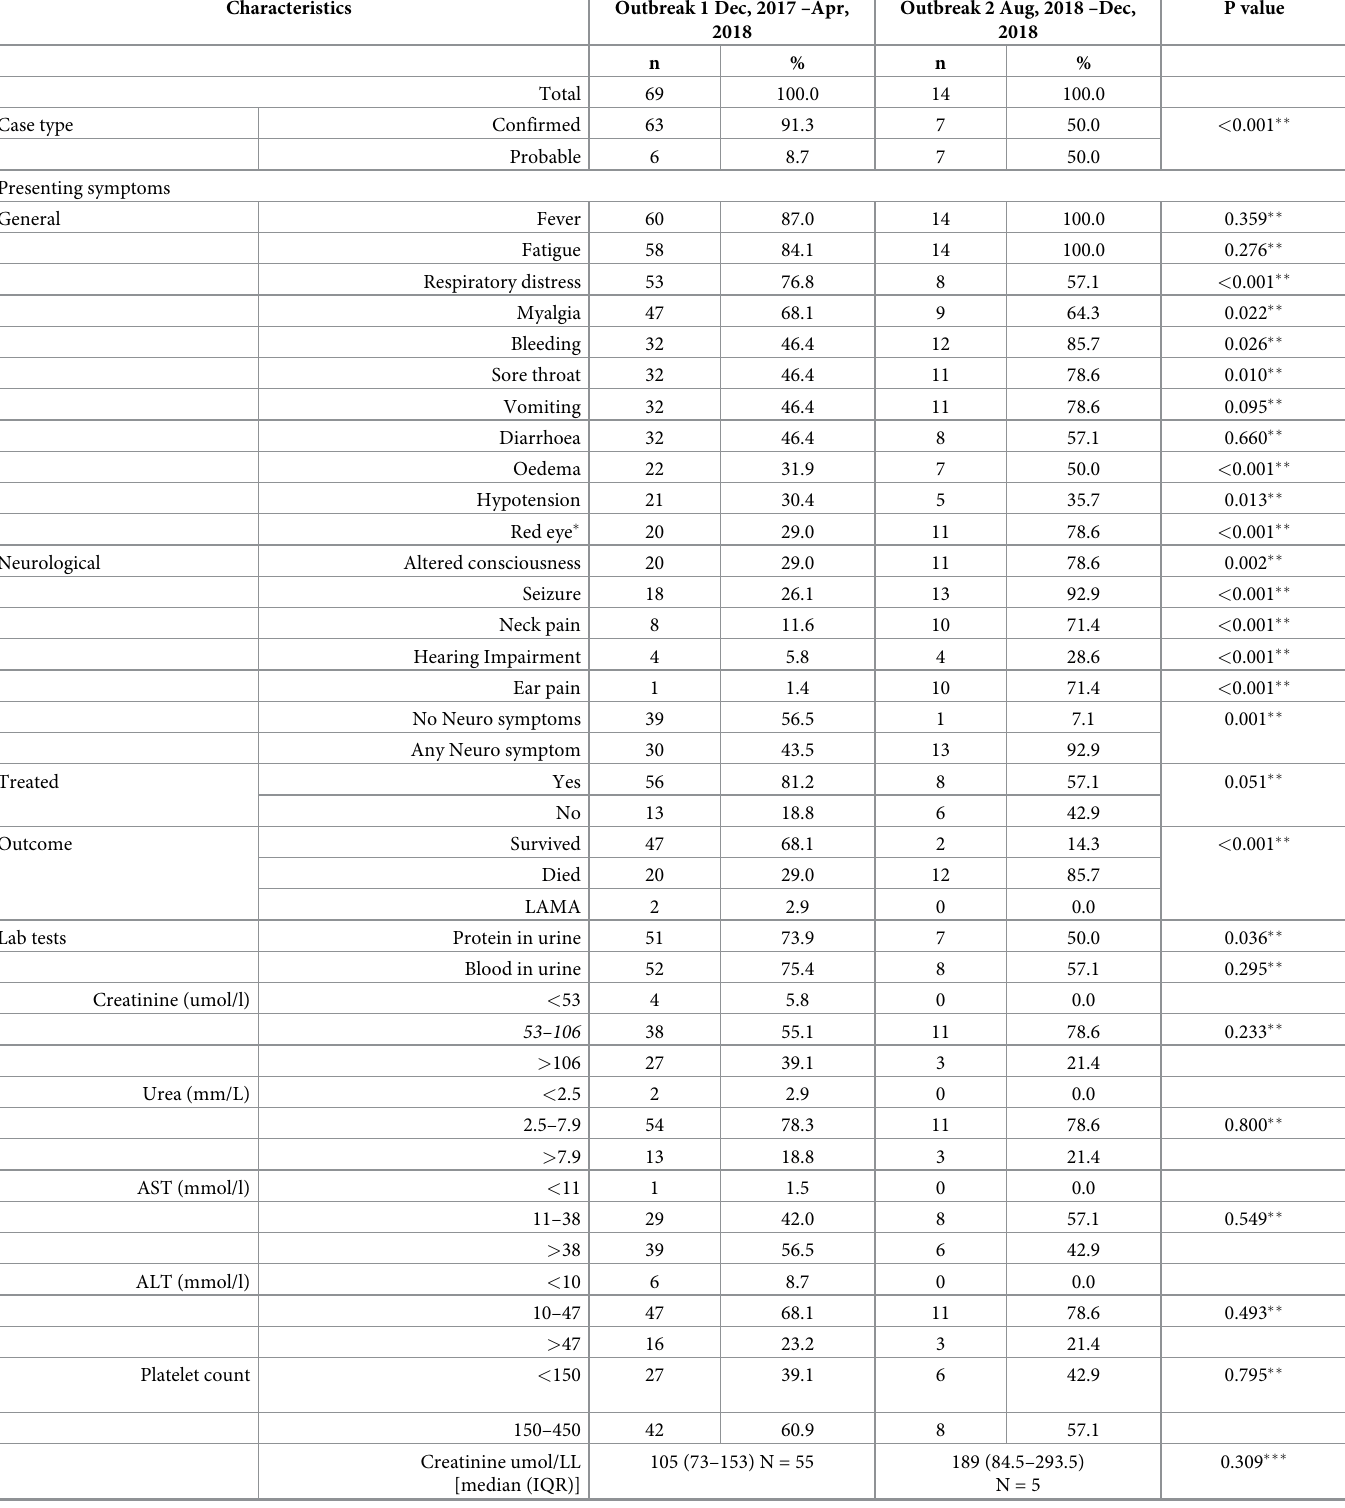
Table 2. Clinical characteristics, hospital management and outcomes of confirmed and probable cases of the two outbreaks.